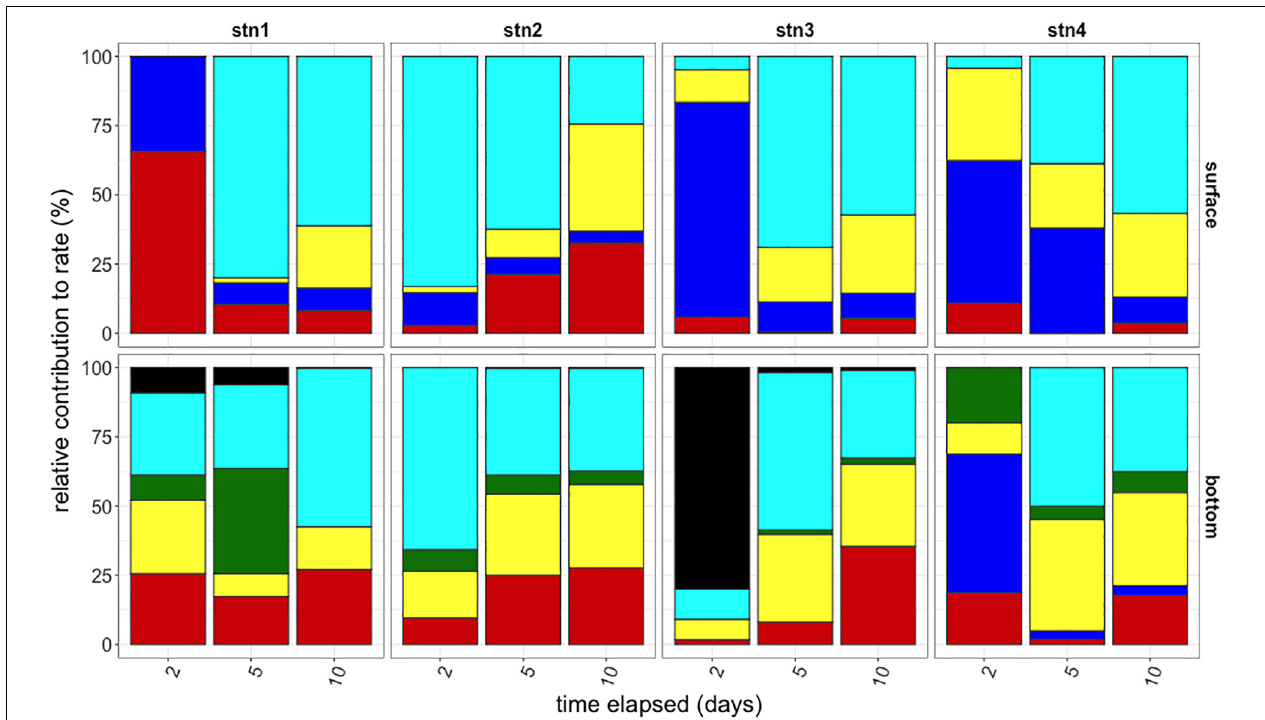
FIGURE 4 | Relative contributions of polysaccharide hydrolase activities to summed hydrolysis rates ( y -axis) at the time of subsampling ( x -axis) for each station (left to right) and depth (top and bottom). Black: arabinogalactan; Turquoise: chondroitin sulfate; Green: fucoidan; Yellow: laminarin; Blue: pullulan; Red: